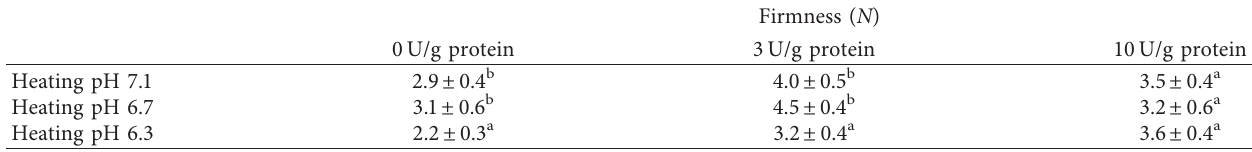
Table 3: Effects of preheating pH and TGase contents on the firmness of acid-induced yak milk gels.